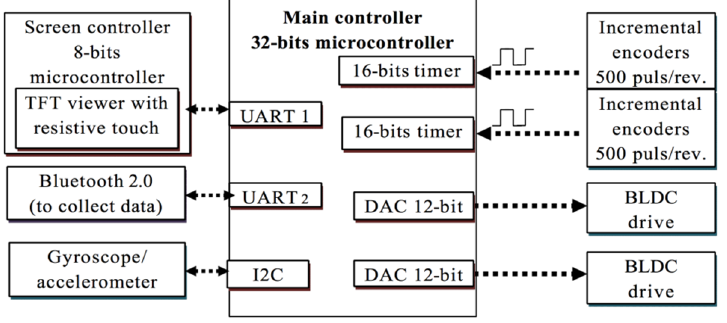
Figure 3. Block diagram of the control system.